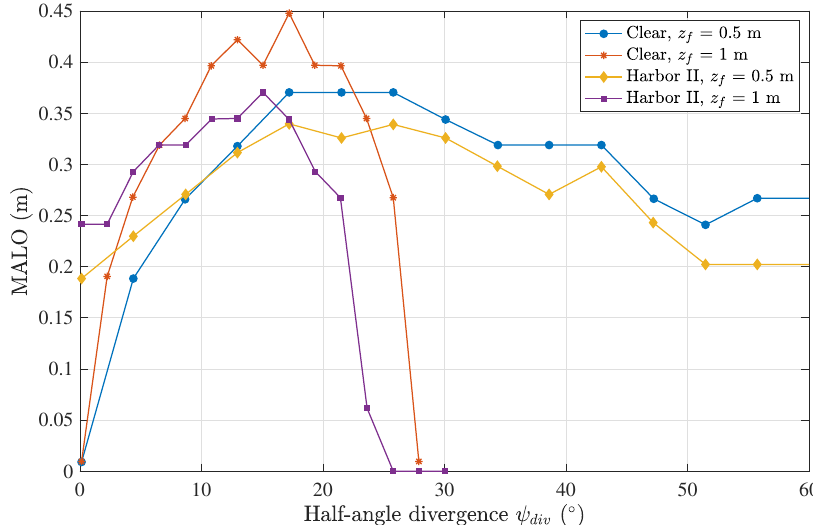
Figure 12. MALO calculation for different water types at different Tx–Rx distances and for varying divergence angles, considering a seven-lens scheme.